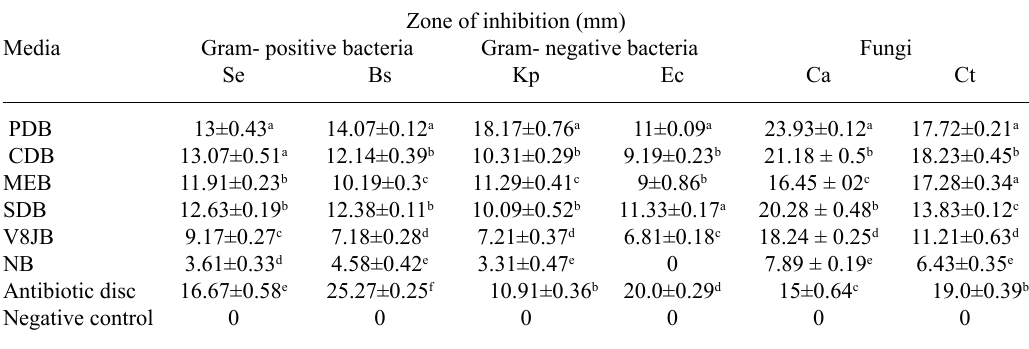
Table 1. Effect of different culture media on the bioactive